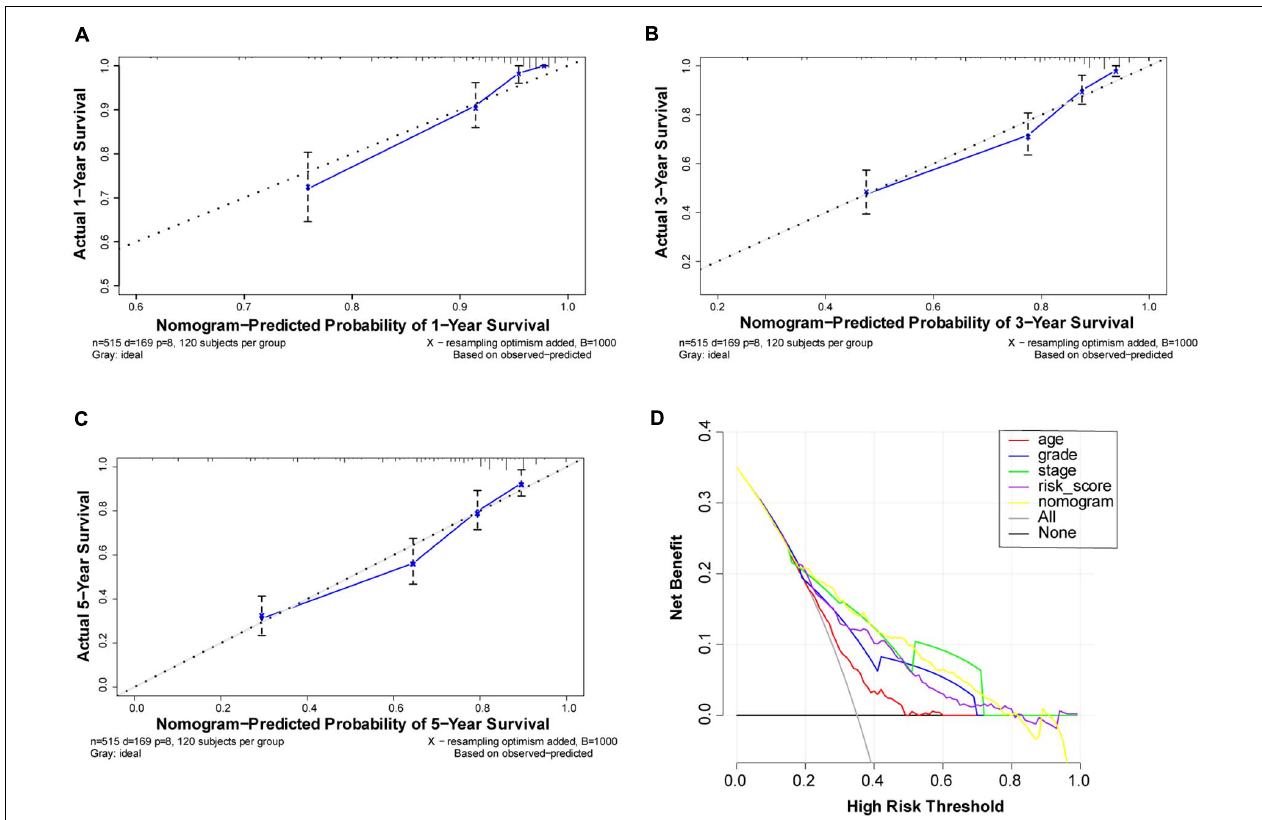
FIGURE 6 | Performance of ferroptosis-related gene (FRG)-based risk score prognostic model. (A–C) Calibration curves of the nomogram for predicting survival at 1, 3, and 5 years. If the actual curve is closer to the ideal curve, the nomogram prediction accuracy is higher (D) Decision curve analysis of this nomogram. Including the risk score model, the nomogram shows that advanced age, grade, risk score, and partially were better than stage for predicting